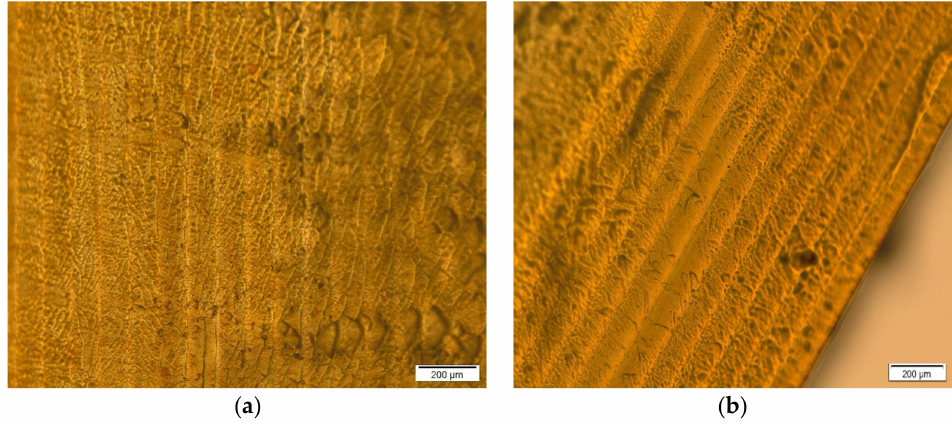
Figure 8. ( a ) Cross-section of placebo tablet; ( b ) cross-section of optimal